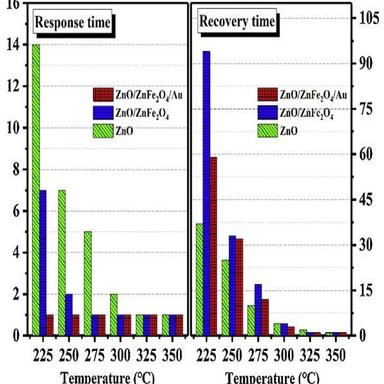
Response and recover time for the three sensors versus operating temperature.